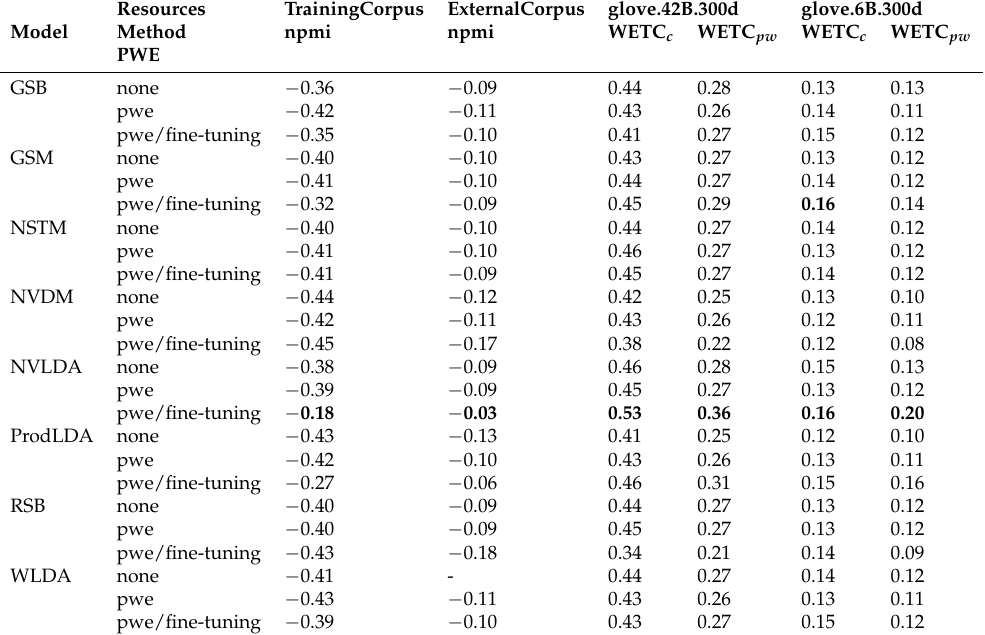
Table 4. Topic Coherence on BBCNews.